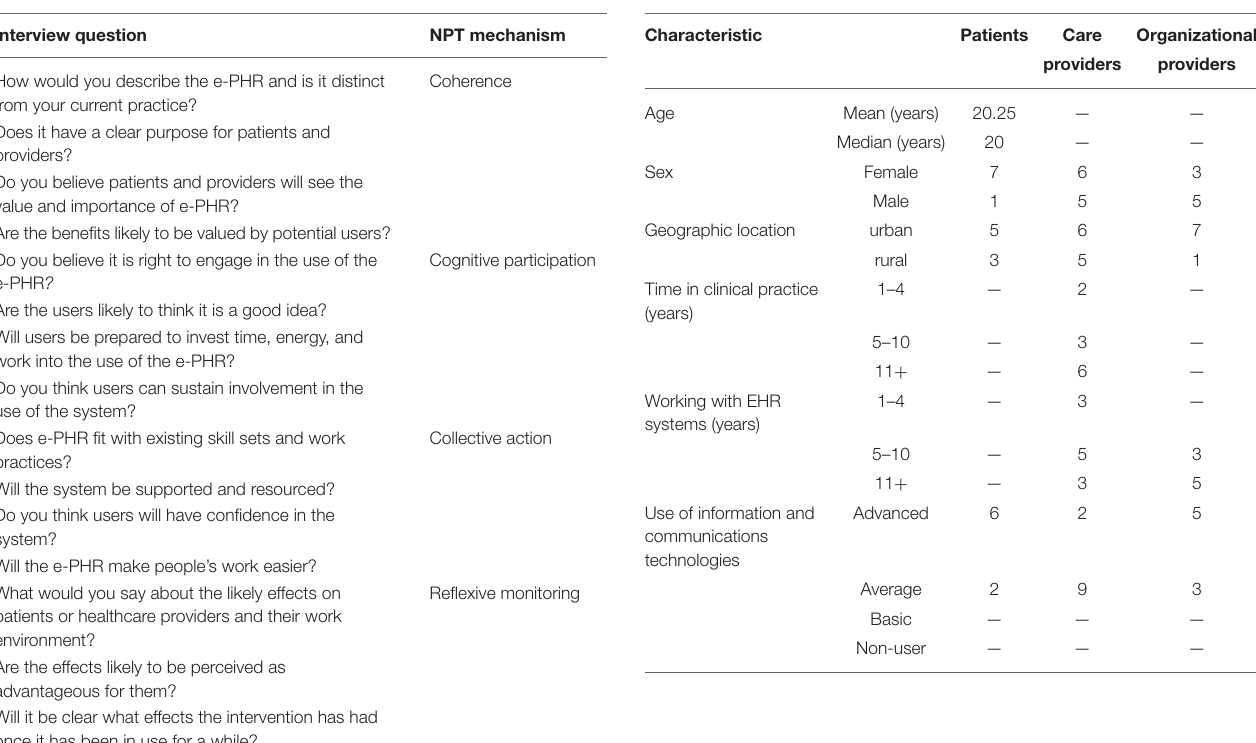
TABLE 1 | Interview questions aligned with NPT. TABLE 2 | Characteristics of study